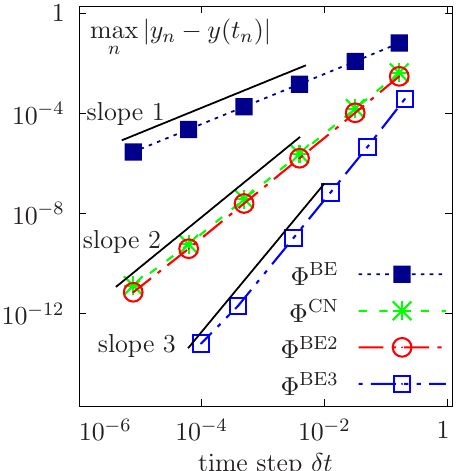
Figure 2. Temporal convergence for different time schemes as a function of constant time steps δ t .